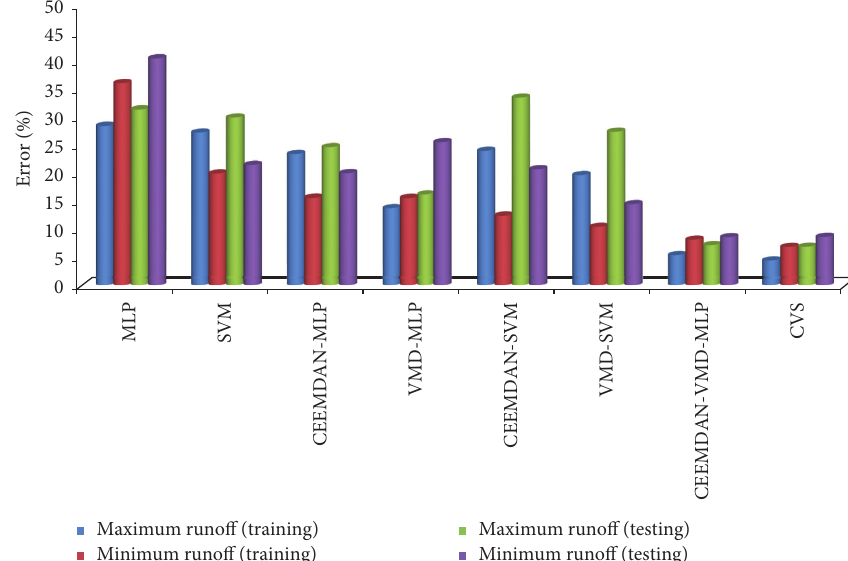
Figure 15: Models’ performance in predicting the extreme values of observed runoff during the training and testing